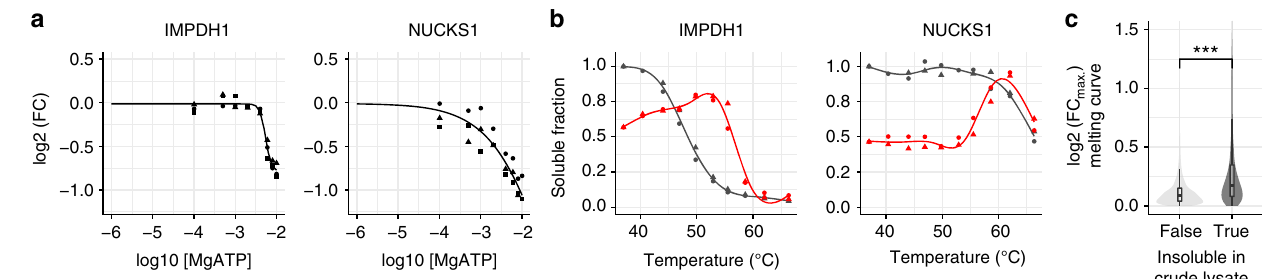
Fig. 5 SPP identi fi es proteins decreasing in solubility upon ATP addition. a Solubility pro fi le for IMPDH1 and NUCKS1, fold change (FC) in y -axis represents the ratio of NP40-processed ATP treated and vehicle-treated conditions from three independent experiments. b Melting curves for IMPDH1 and NUCKS1 from two independent TPP experiments in crude lysates treated with vehicle (black) or 10 mM ATP (red) and corrected for solubility changes at 10 mM ATP using SPP data. c Maximal log2 fold changes observed for melting curves of insoluble versus soluble proteins in untreated crude lysate. Signi fi cance levels obtained from a Wilcoxon signed-rank test were encoded as * p < 0.05, ** p < 0.01, and *** p < 0.001. Violin plots represent relative densities. For all box plots, the center line is the median, bounds of the boxes are the 75 and 25% percentiles (i.e., the IQR), and whiskers correspond to the highest or lowest respective value. If the lowest or highest value is an outlier (greater than 1.5*IQR from the bounds of the boxes) whiskers are exactly 1.5*IQR. Numbers above violin plots represent number of proteins. Source data are provided as a Source Data fi le for all